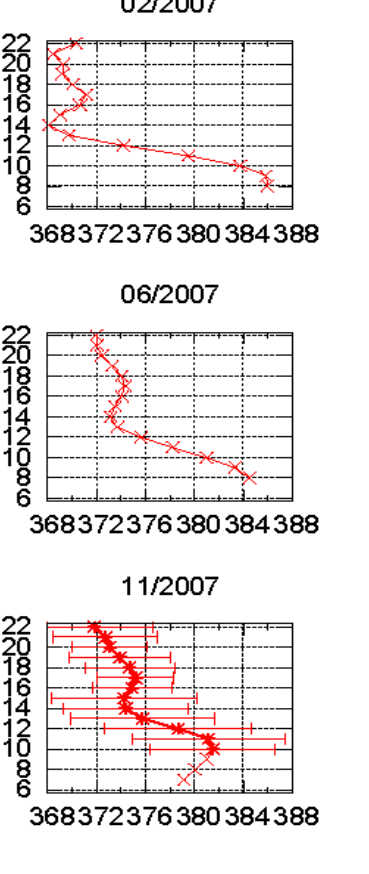
Fig. A3. Same as Fig. A1 for